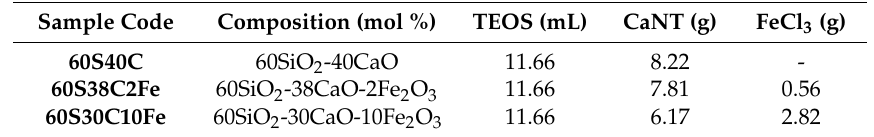
Table 1. Nominal compositions (mol %) and reactants of the sol-gel materials produced in this work a . Sample